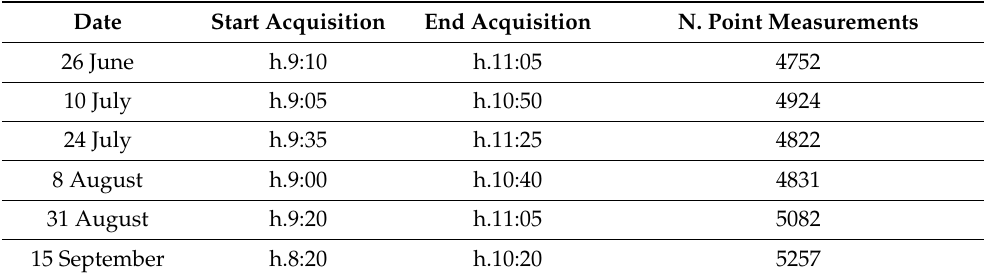
Table 4. Details of the EMI campaigns: date, starting and ending time of acquisition; and number of point measurements for each campaign.